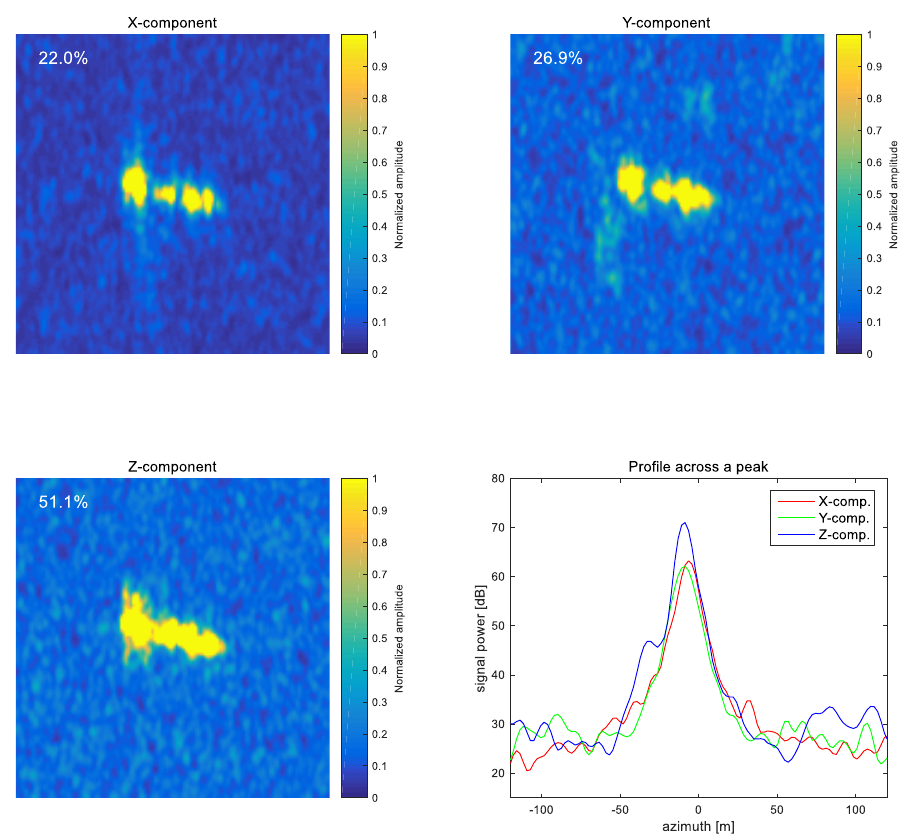
Figure 4. Three different views computed from a typical ship with a window containing 129 by 129 sub-samples. The positive high Doppler frequency component was assigned to the X-axis ( upper left ), the negative high Doppler frequency component was assigned to the Y-axis ( upper right ), and the low Doppler frequency component was assigned to the Z-axis ( bottom left ). Azimuth profiles across a peak were also compared ( bottom right ), and the maximum peak powers of the X- and Y-components were no lower than 5 dB compared with the Z-component. The summed signal power of the Z-component accounted for 51.1% of the total signal power, and the X- and Y-components accounted for about 22.0% and 26.9%, respectively.